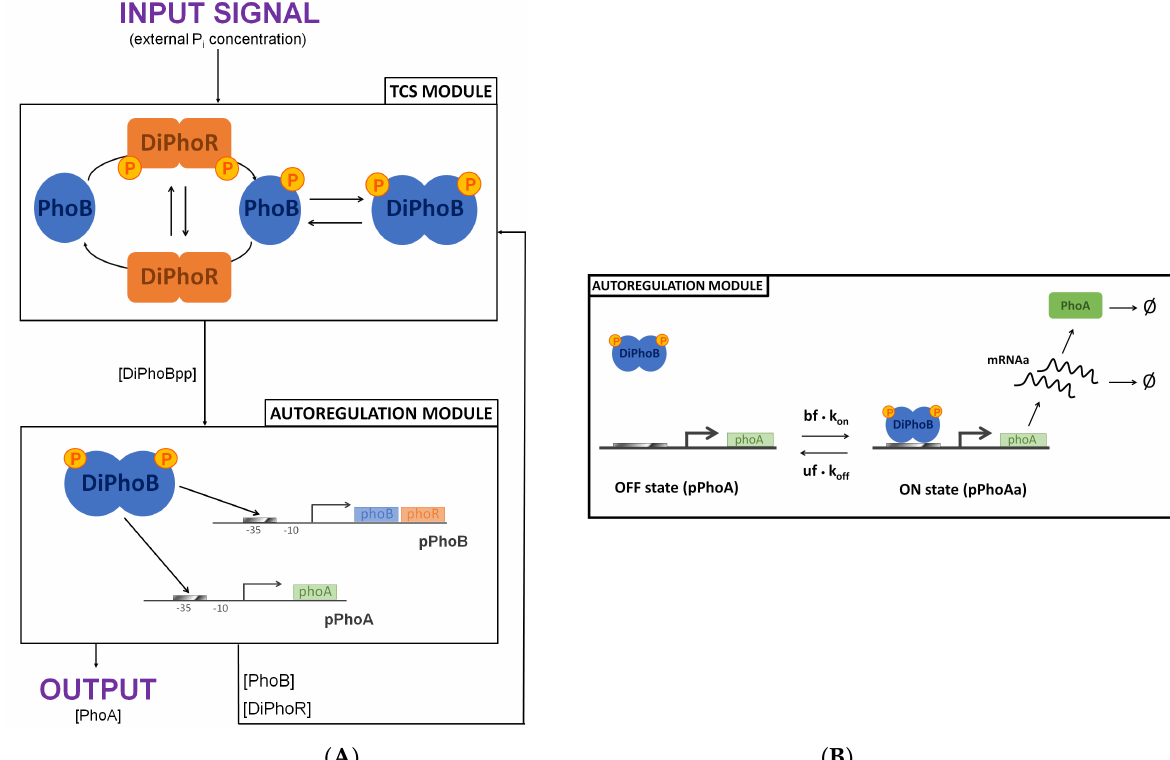
Figure 6. The two interconnected regulatory modules of the PhoBR TCS. ( A ) The TCS module includes the interactions between the histidine kinase and the response regulator, that is, PhoR autophosphorylation and the reverse reaction, PhoB phosphorylation by phosphotransfer and PhoB dephosphorylation by PhoR acting as a phosphatase. The full model takes into account the PhoR and PhoB dimeric nature together with the intermediate complexes formed by interacting proteins. In contrast, the reduced model abstracts away from the dimeric structures of TCS components and neglects the protein complexes. The autoregulation module receives DiPhoBpp concentration as input to transcription control. It includes transcription and translation processes for the expression of phoBR and phoA genes and protein degradation/dilution. The reduced model represents transcription and translation in a single step. The system output can be quantified by the active transcription factor (DiPhoBpp) level as it regulates the gene products of the PhoBR operon, including PhoB and PhoR as well as others [29]. In turn, PhoB and PhoR concentrations are inputs for the TCS module together with the external P i concentration. ( B ) Close-up view of the two-state promoter model for the phoA promoter in the autoregulation module. The dimensionless scaling factor uf and bf are applied to DiPhoBpp binding rate k on ( µ m − 1 s − 1 ), associated with reactions r16 and r18 , and unbinding rate k of f (s − 1 ), associated with reactions r17 and r19 , to scan different binding affinities identified by the dissociation constant K d = k of f / k 0 on ; k on depends on DiPhoBpp concentration, k on = k 0 on [ DiPhoBpp ]